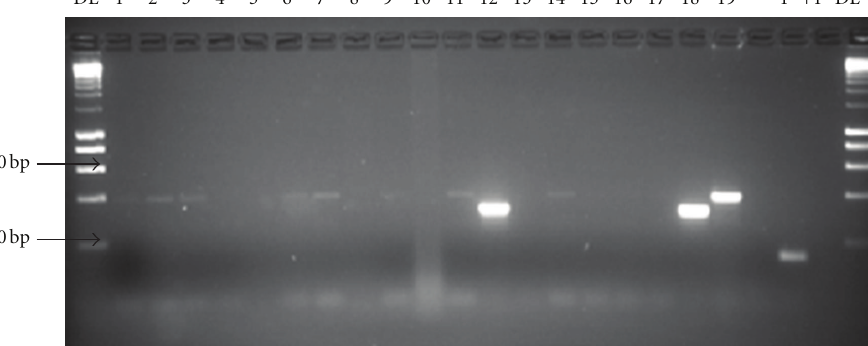
Figure 3: DNA bands produced by ribosomal DNA-polymerase chain reaction (PCR) amplification from the di ff erent species in the Anopheles gambiae complex from Chazanga. DL: 1-kp DNA ladder size standards, +1: positive control ( A. arabiensis ), − 1: negative control. The sample DNA in each of the lanes was as follows: 1, 2, 3, 6, 7, 11, and 14 were amplified for A. gambiae ss. (390 bp). 12 was amplified for A. arabiensis (315 bp).